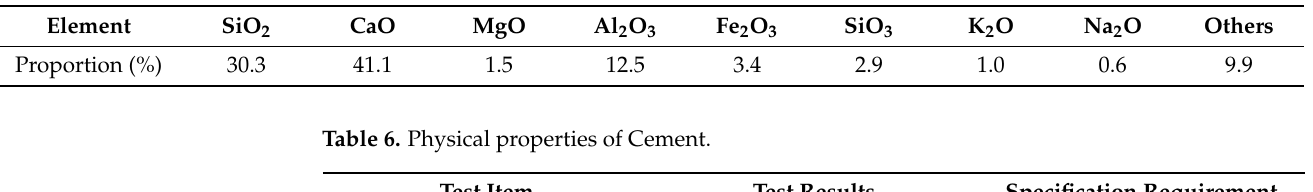
Table 5. Chemical composition of the P · O42.5 cement.